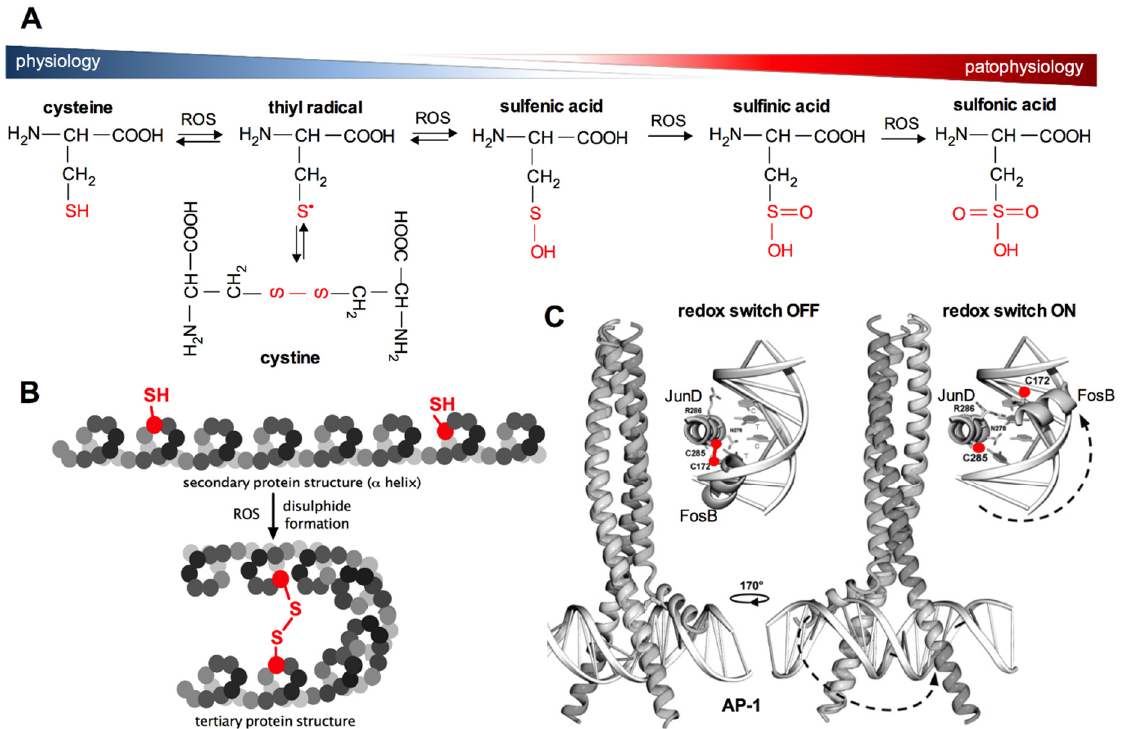
Figure 3. Oxidation of the sulfhydryl group of cysteine. Panel ( A )—physiological (disulfide, sulfenic acid) and pathophysiological (sulfinic and sulfonic acid) products of cysteine oxidation. Panel ( B )—the effect of disulfide bond formation on protein α -helix conformation. Panel ( C )—mechanism of redox regulation on the example of the transcription factor AP-1 (activating protein 1). The enlarged view shows the DNA binding units (JunD and FosB) of AP-1. The disulfide bond between JunD and FosB (redox switch OFF) must be reduced to sulfhydryl groups to allow FosB subunit to bind to DNA (redox switch ON). Disulfide reduction is accompanied by conformational changes (dashed lines) [computer visualisation adopted from Yin et al. [78].